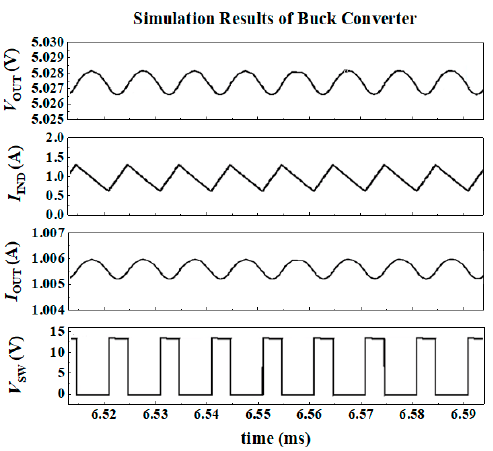
Figure 11. Simulation results of buck converter ( V IN = 14.5 V, V OUT = 5 V, I load = 1 A).